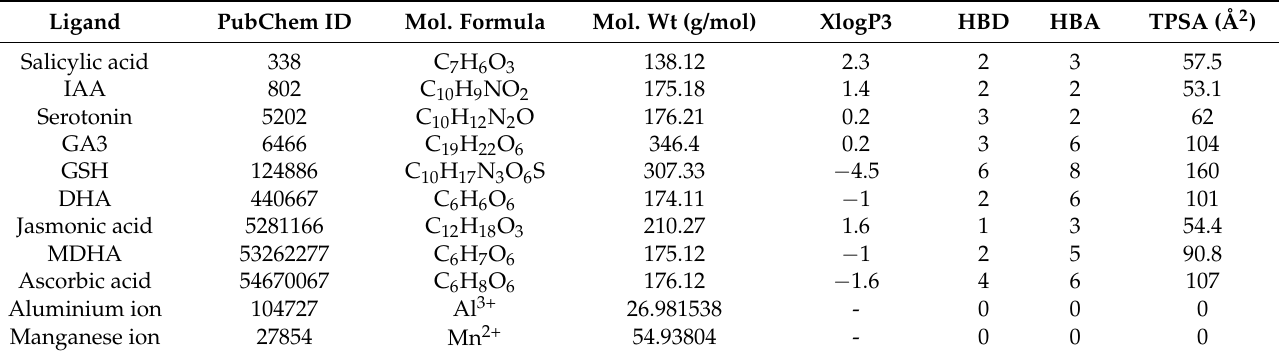
Table 1. Details of the compounds/ligands used in the study. XlogP3: Octanol-water partition coefficient; HBD: Number of hydrogen bond donor acceptor; HBA: Number of hydrogen bond acceptor; TPSA: Topological polar surface